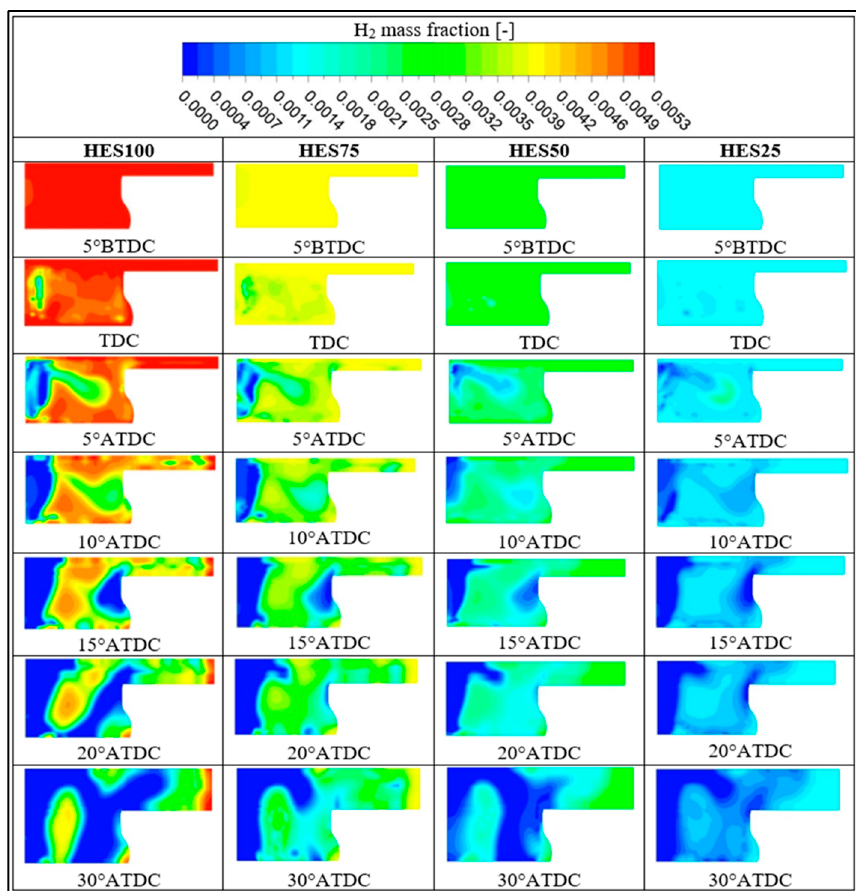
Figure 23. Hydrogen mass fraction distributions for the different HES cases .